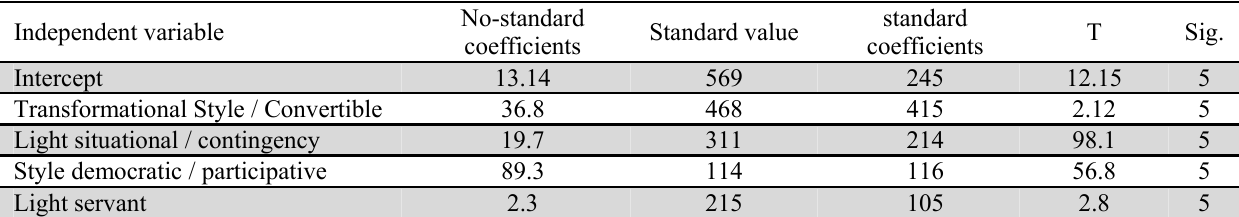
The summary of regression analysis Independent